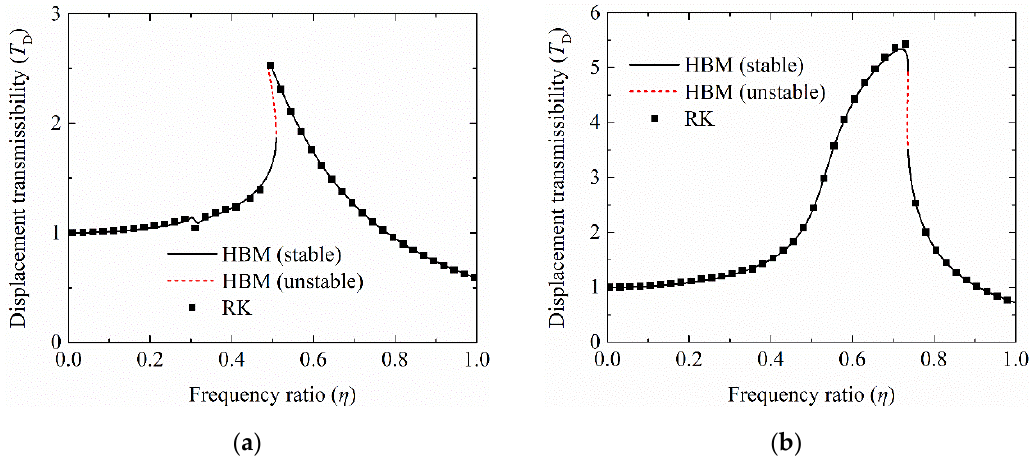
Figure 11. The frequency responses with jump phenomena. ( a ) Stiffness softening and ( b ) stiffness hardening.